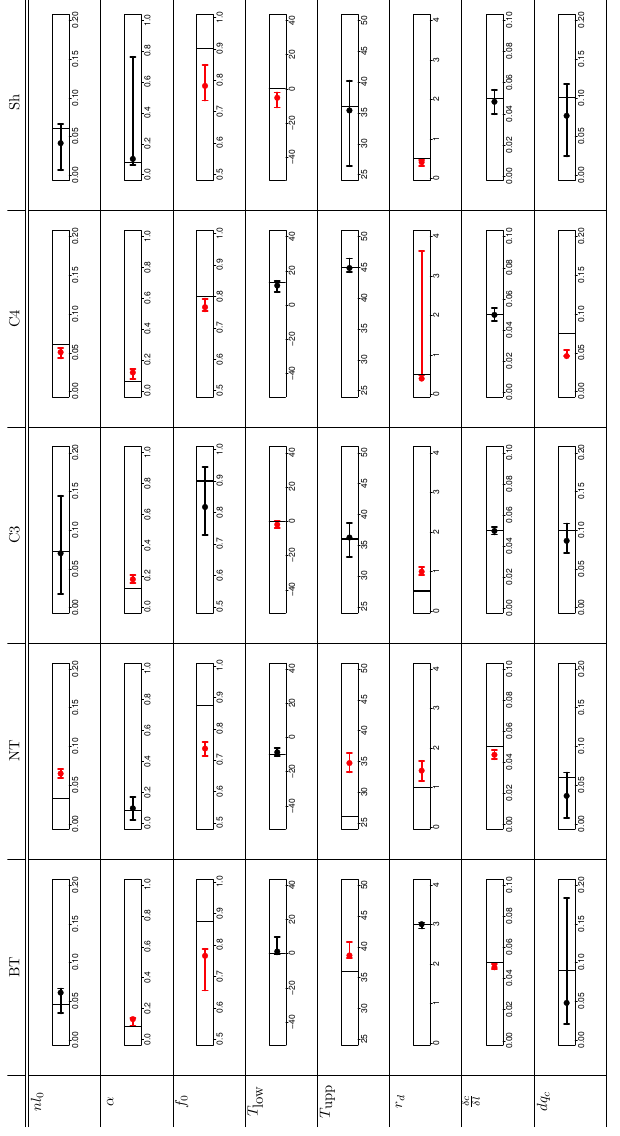
Figure 3. Summary of PFT-specific optimal JULES parameters found in this study (Table 1). The error bars show the uncertainty ranges given as an 80% quantile interval. The range of each box is the prior range of the parameters. Highlighted in red are the error bars for which the prior values (vertical line) are found outside the posterior uncertainty bounds. A numerical version of this figure is given in Table